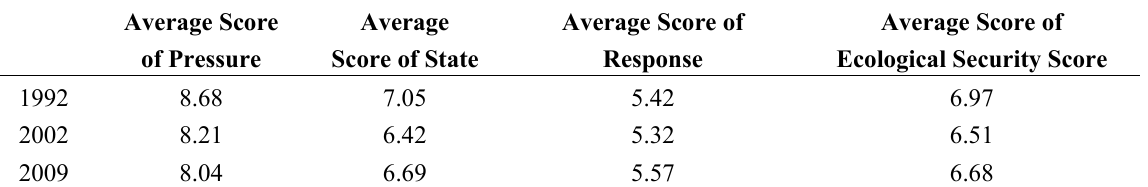
Table 4. Average score of costal wetland ecological security of Yancheng city.